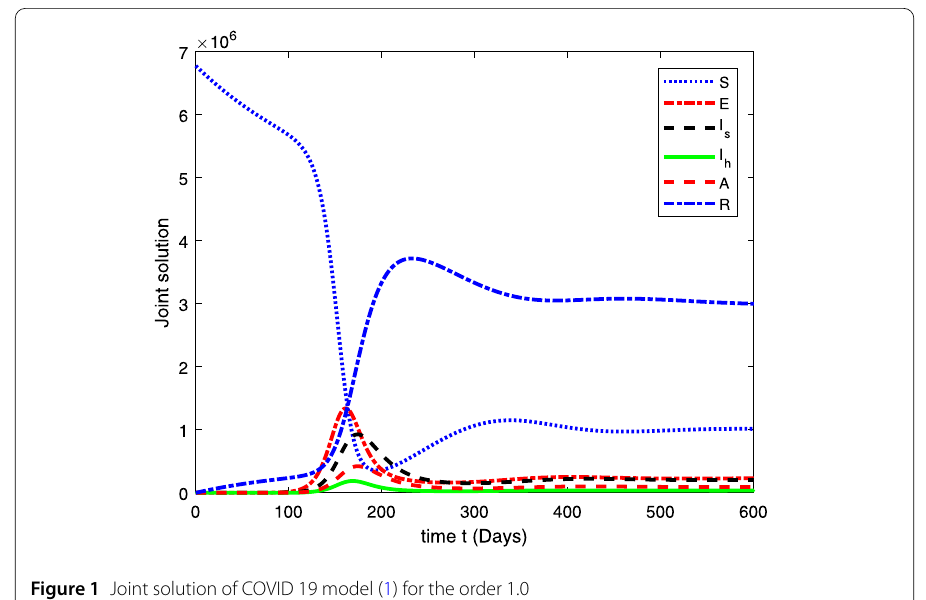
Figure 1 Joint solution of COVID 19 model (1) for the order 1.0